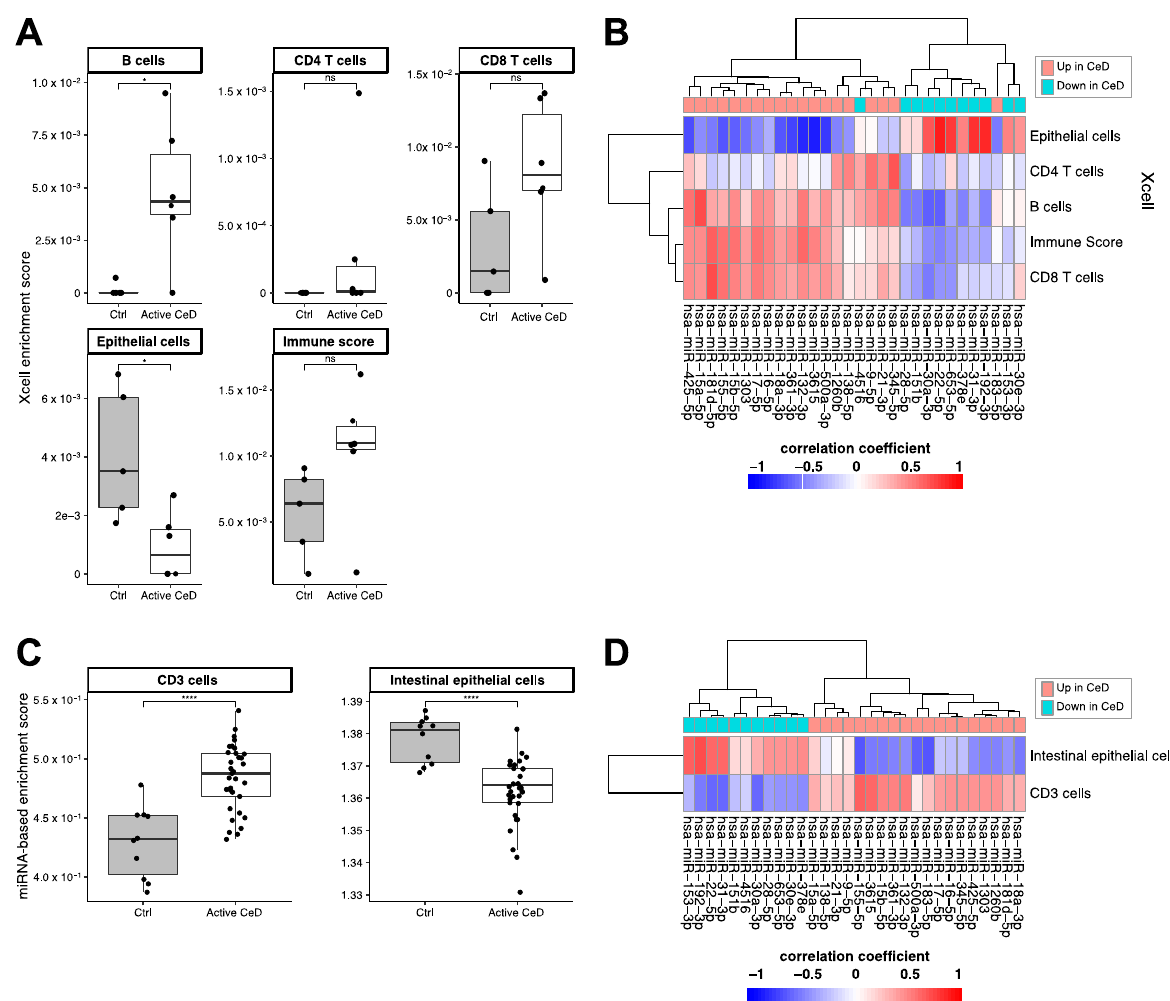
Figure 5. Cell type–enrichment based on Xcell enrichment scores calculated from the RNA-seq data ( A , B ) or based on the miRNA based cell type–enrichment score ( C , D ). ( A ) Immune cell enrichment scores show an increased trend in CeD. Epithelial cells show a lower enrichment in CeD. ( B ) Heatmap showing the (unscaled) Pearson’s R correlation coefficient between miRNA levels and the cell type–enrichment score. miRNAs that are downregulated in CeD (blue) show a high positive correlation with epithelial cells, whereas upregulated miRNAs show the opposite trend. ( C ) Enrichment for CD3+ associated miRNAs is increased in CeD. Enrichment for epithelial-specific miRNAs is lower in CeD than in controls. ( D ) Heatmap showing the (unscaled) Pearson’s R correlation coefficient between miRNA levels and the enrichment for CD3+ or intestinal epithelial cells. Mann-Whitney U P-value: n.s. >0.05, * 0.01–0.05, **** <0.0001.